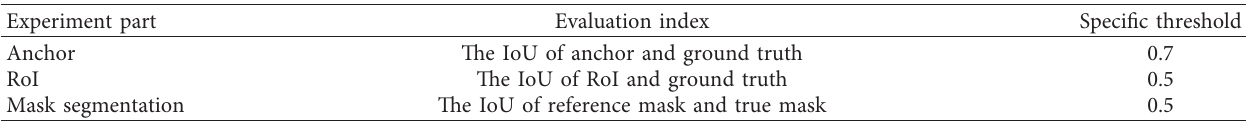
Figure 7: Pixel expansion. (a) A fixed-size subimage with the center of the circle as the center is taken. (b) The center of the circle is too close to the boundary. (c) After filling, there will be no out of bounds. Table 1: The specific threshold data of the